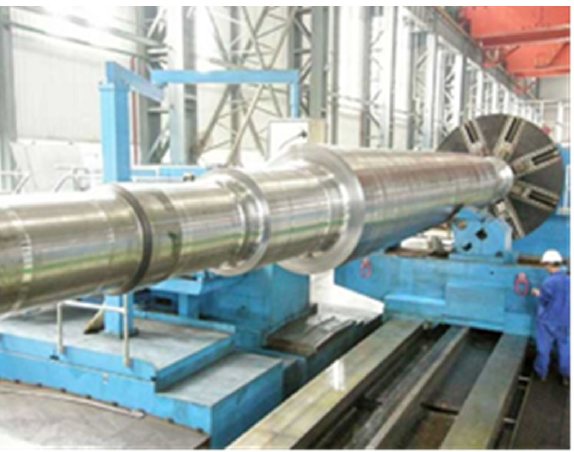
Figure 1. Example of a rotor of a synchronous generator of hundreds of MVA.